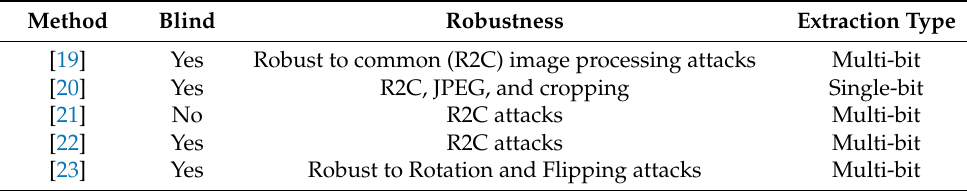
Table 1. Literature review of watermarking